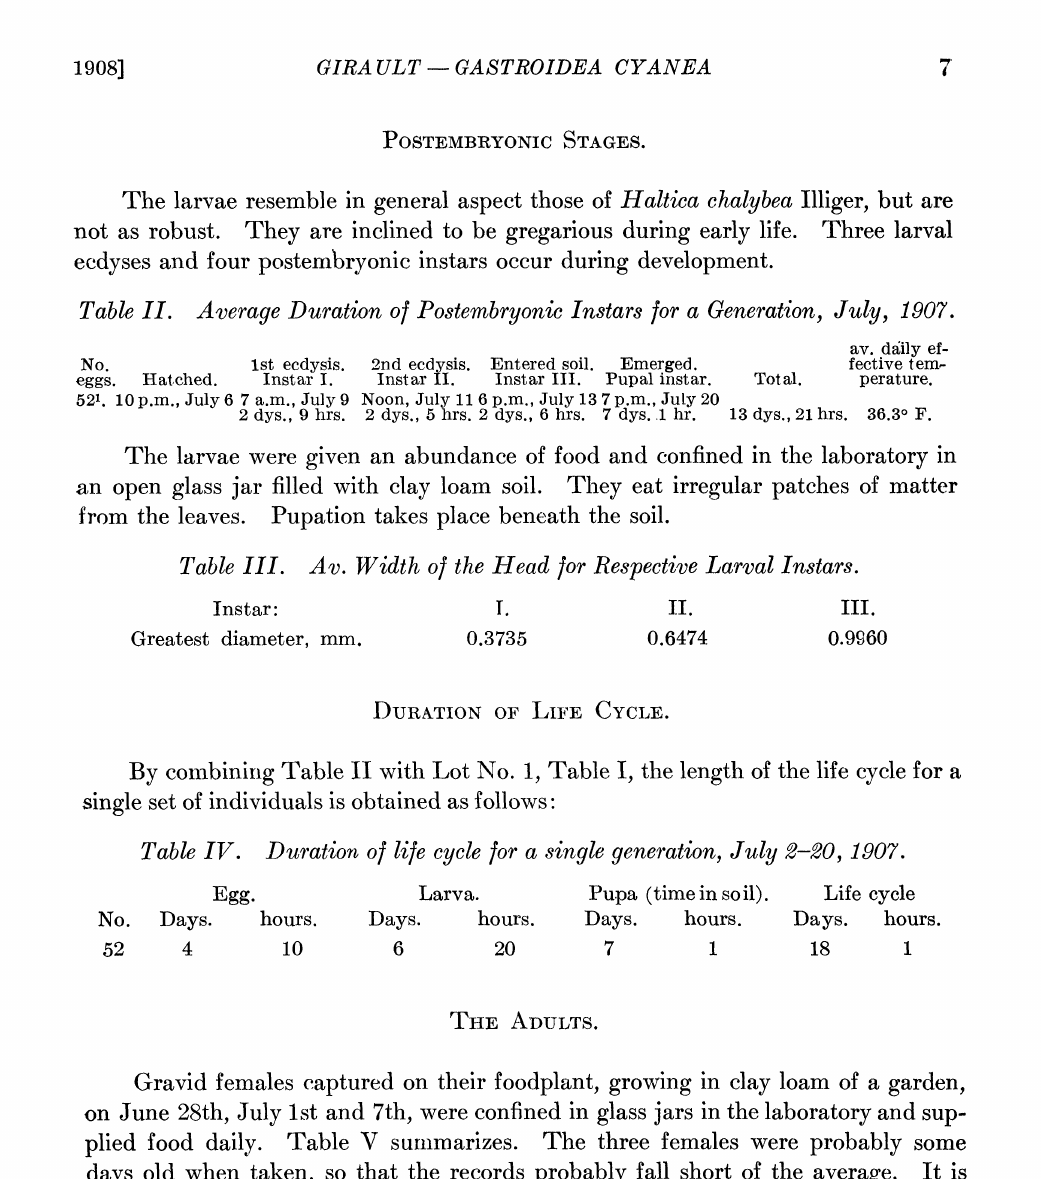
Table II. Average Duration